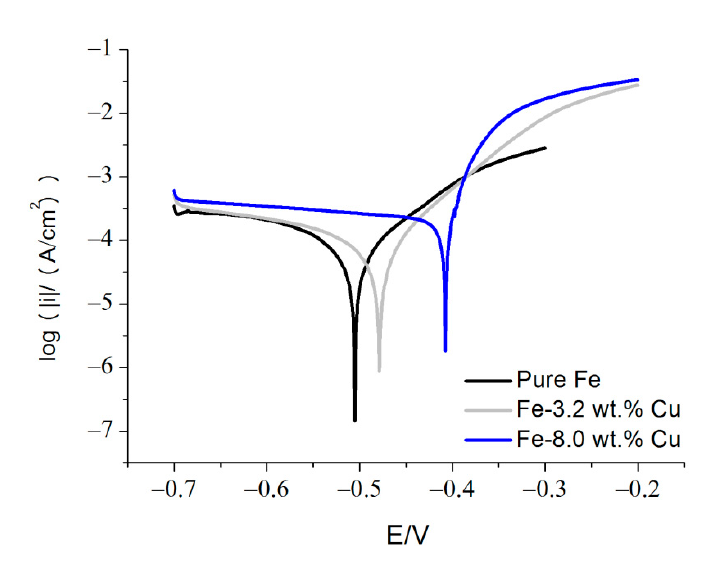
10 of 13 Figure 8. Cumulative relative frequency of occurrence as a function of hardness number. Potentiodynamic polarization measurements and porosity estimations revealed that the corrosion potential, corrosion current density, and total porosity increased as the con- tent of copper in specimens was increased (Figure 9, Table 2). Since the previous study [29] revealed that the corrosion potential of sintered pure iron decreased when its porosity was increased, it is assumed that it is the presence of copper with its higher electrochem-